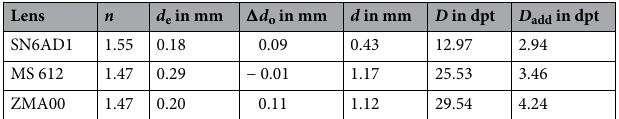
Table 3. Lens properties.